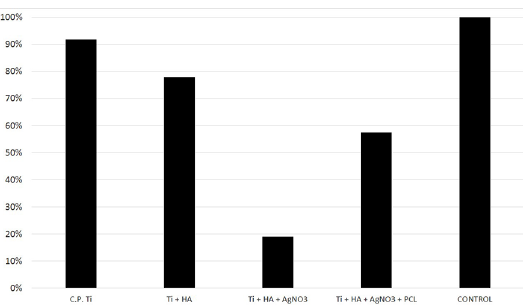
Figure 5 . Polarization curves obtained in SBF solution, at 36.5 ºC and pH 7.4, for the samples: C.P. Ti, Ti + HA + AgNO HA + AgNO + PCLw 3